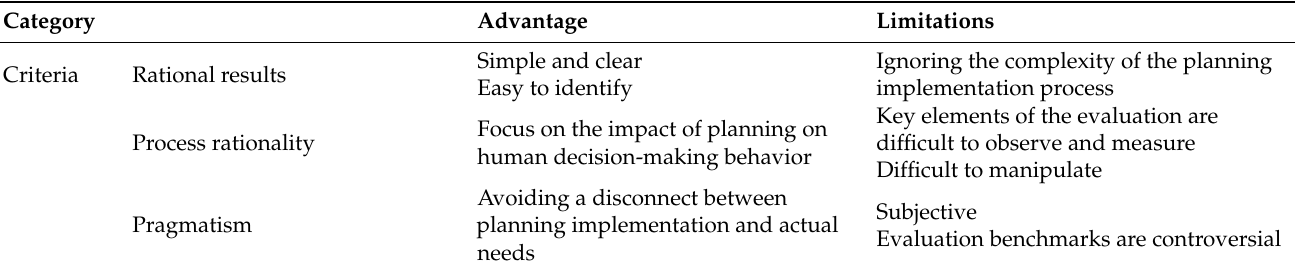
Table 1. Summary of criteria, frameworks and methods for evaluating the effectiveness of planning